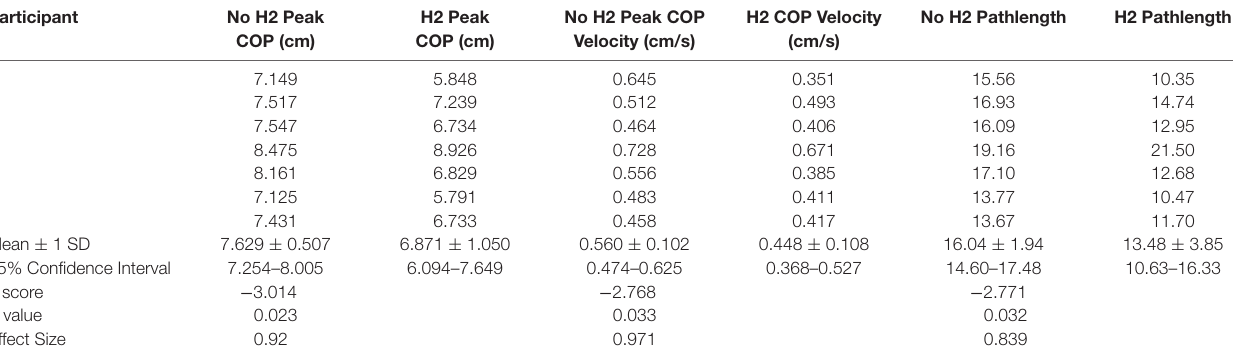
TABLE 2 | Peak COP, Peak COP Velocity, and maximum Pathlength in response to backward translations with and without wearing the H2 exoskeleton. Participant